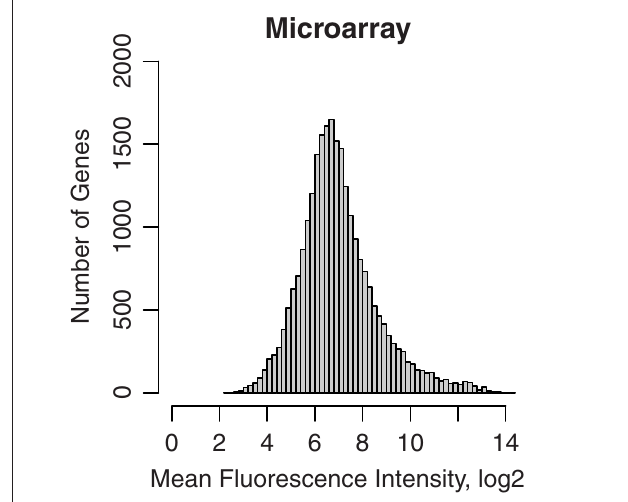
FiGuRe 1 | Microarray gene expression profiles of GABAergic neurons projecting from nucleus accumbens shell to ventral pallidum. These projection neurons were labeled retrogradely by Fluorogold and were obtained by laser capture microdissection. RNA were extracted and amplified before hybridization to Affymetrix rat ST 1.0 microarrays. Background noise, estimated using the antigenomic controls, were subtracted and signals were normalized using the Bioconductor xps package. The distribution of mean microarray signal intensities for all gene transcripts detected in four rat samples from nucleus accumbens of inbred Lewis rats were plotted. The median fluorescence signal intensity was 6.78. Thus, LCM samples provided sufficient RNA for amplification and reliable detection of the